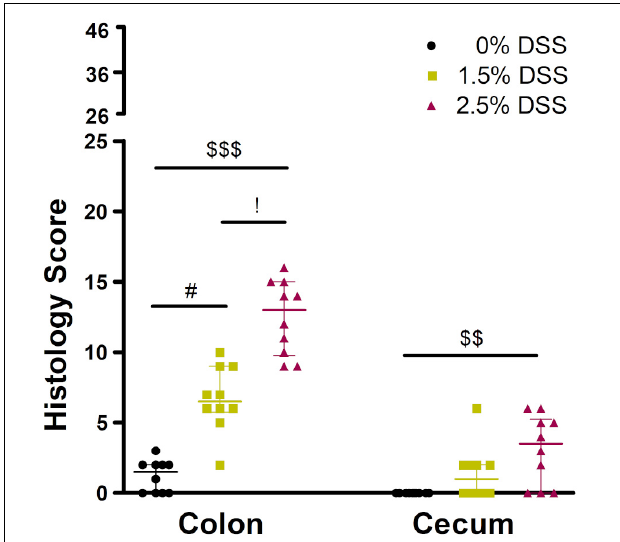
FIGURE 1 | Histology of the three groups of the DSS-induced colitis model. The histology score of the colon ranged from 0 to 46 and of the cecum from 0 to 23. N = 10 animals in each group. Comparison between the groups: Kruskal-Wallis Test (colon: H = 24.17, p < 0.0001; cecum: H = 10.93, p < 0.0042) + Dunn’s post hoc test; #: 0% vs. 1.5% (adj. p < 0.0357), $$: 0% vs. 2.5% (adj. p < 0.0029), $$$: 0% vs. 2.5% (adj. p < 0.0001), !: 1.5%